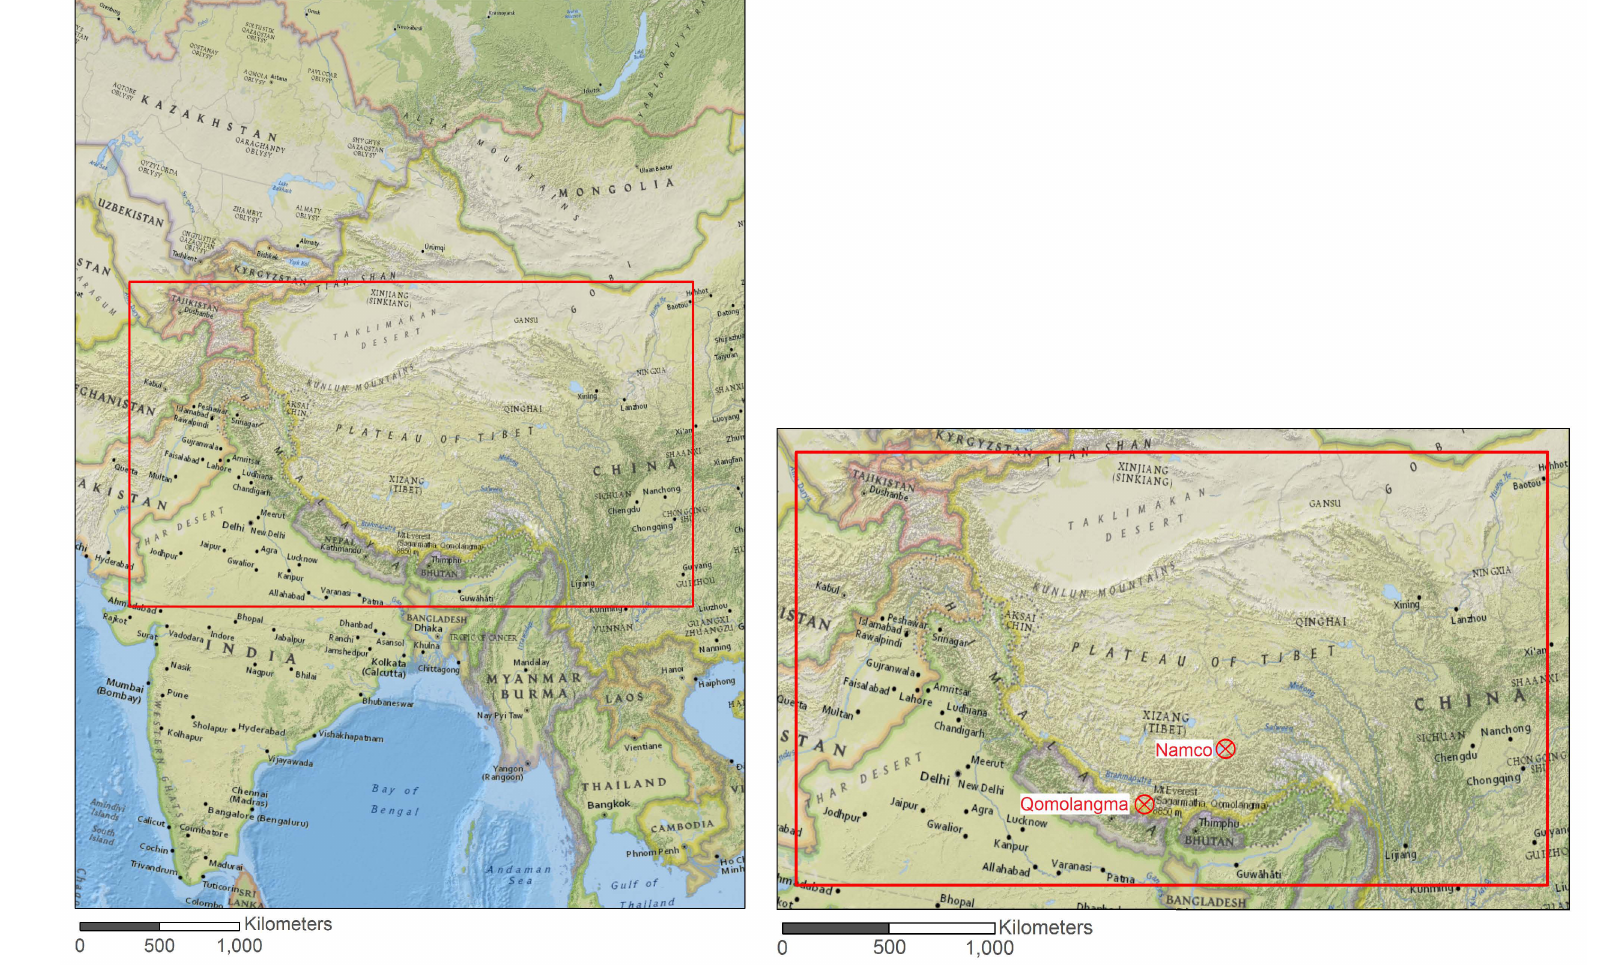
Figure 1. The Tibetan Plateau and surroundings, with the study area extent delimitation (red line), and location of the ground stations (circled red crosses) within the study